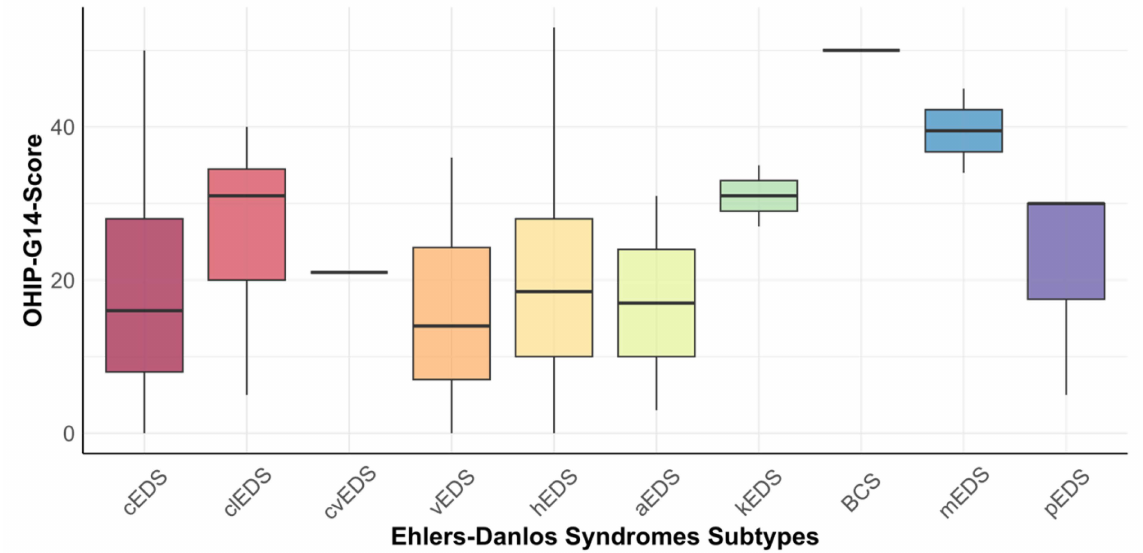
Figure 1. Boxplots for Oral Health Impact Profile-14G across all included